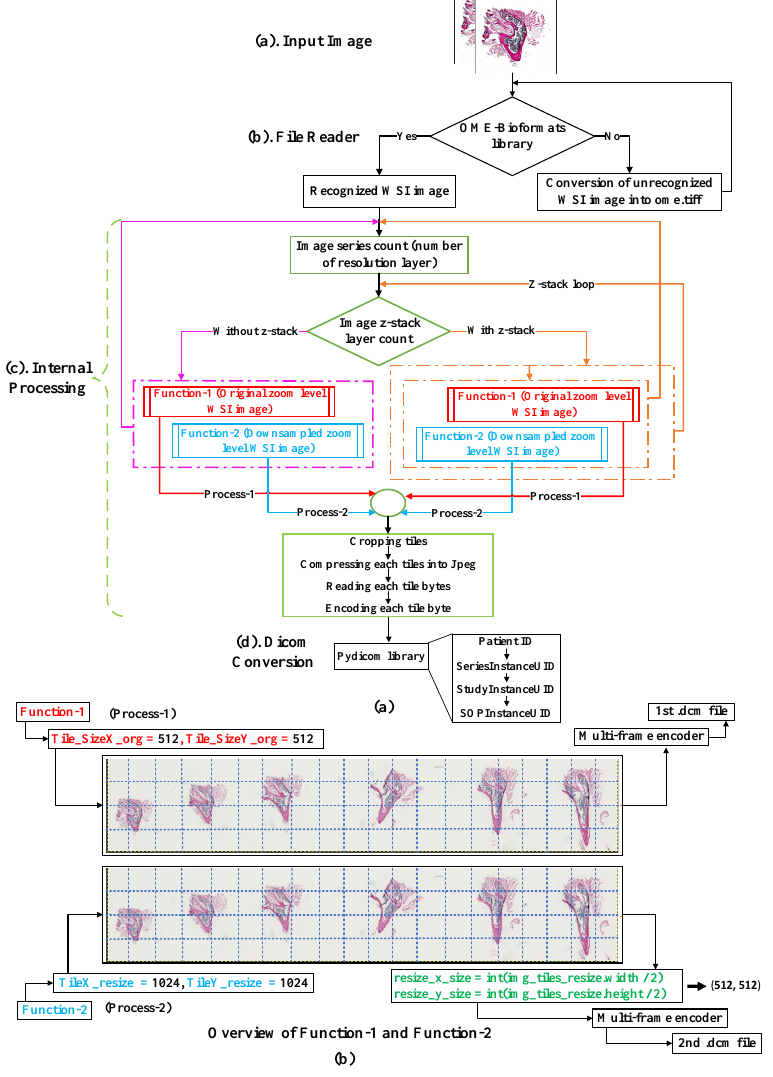
Figure 5. Pipeline for the conversion of WSI imaging modalities into standard DICOM ( a ) Workflow of the pipeline, ( b ) Overview of function-1 and